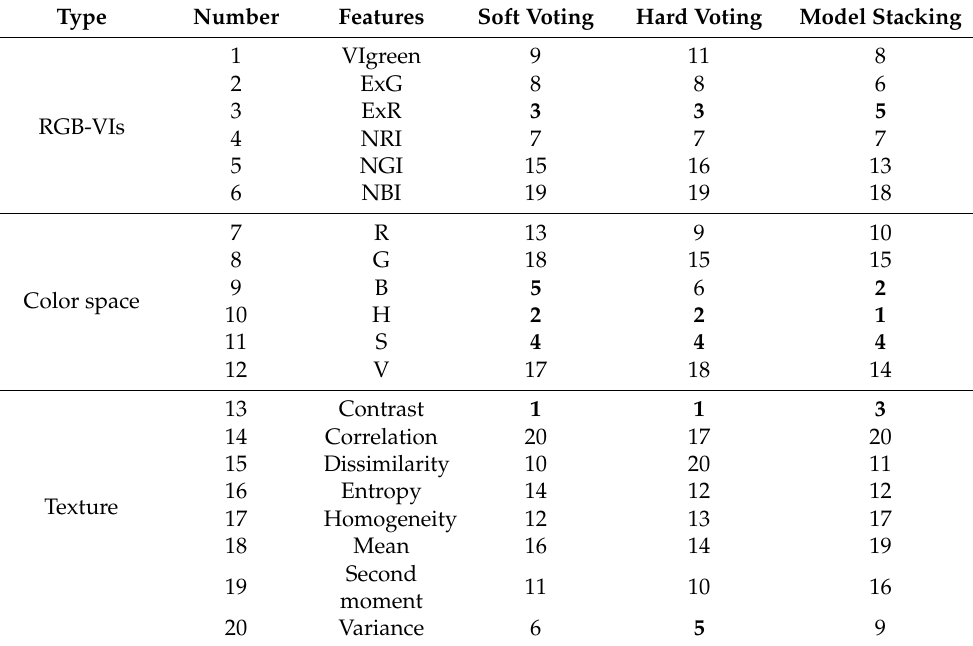
Table 5. Feature ranking in ensemble models based on variable